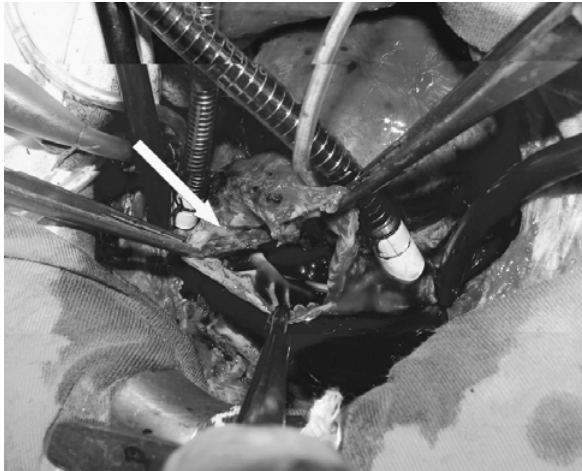
Fig. 2 - Corpo estranho intra-atrial